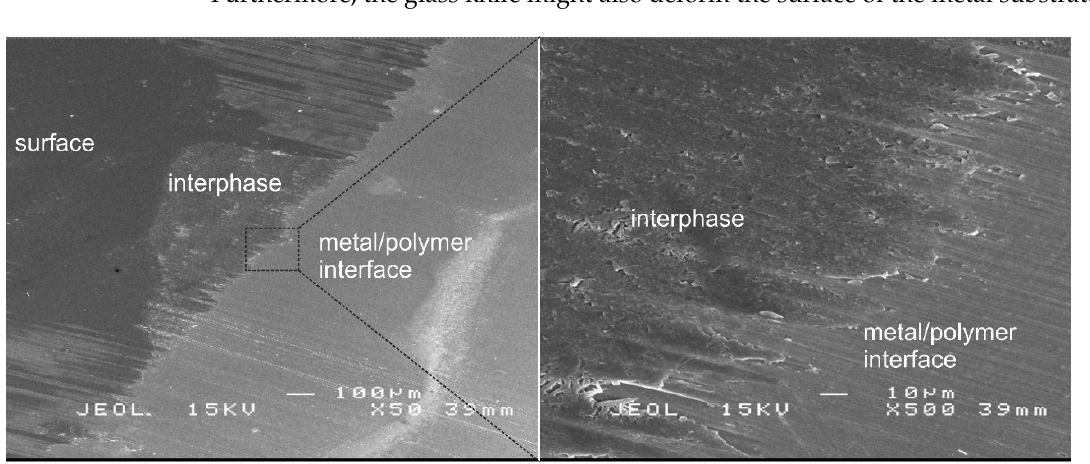
Figure 5. SEM images of a cryo-ULAM cut at magnifications of 50× ( left ) and 500× ( right ).